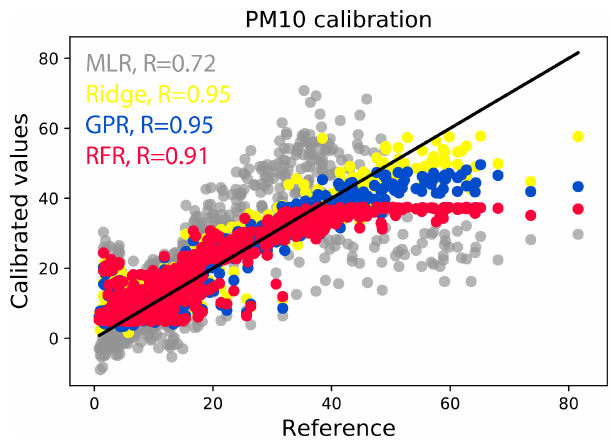
Figure 6. Calibrated PM 10 values (in µgm − 3 ) versus the reference measurements for 900h of test data at location CarPark for the I 24 predictor set-up. The ideal 1 : 1 perfect prediction line is drawn in black. Inset values R are the Pearson correlation